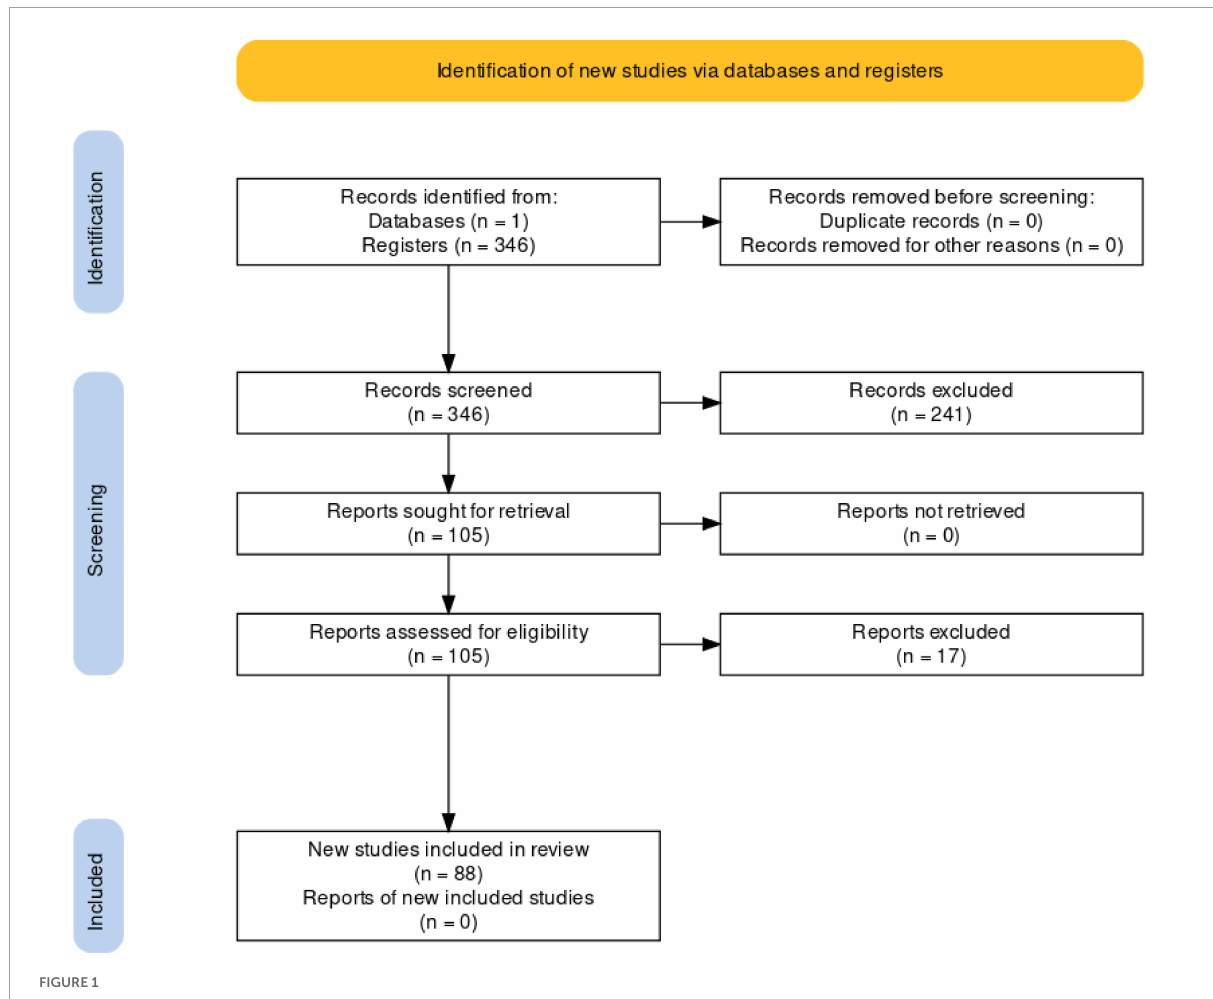
FIGURE1 Study identification procedure (PRISMA).